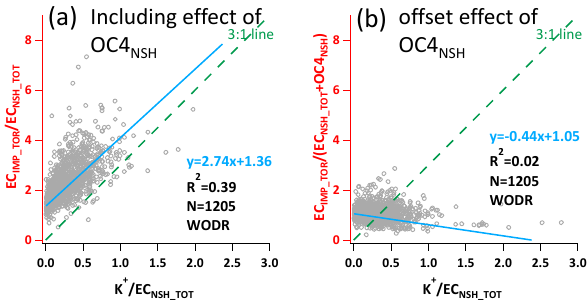
Figure 5. EC IMP_TOR -to-EC NSH_TOT discrepancy depen- dency on K + / EC NSH_TOT ratio (biomass burning effect). K + / EC NSH_TOT ratio–ratio plot.